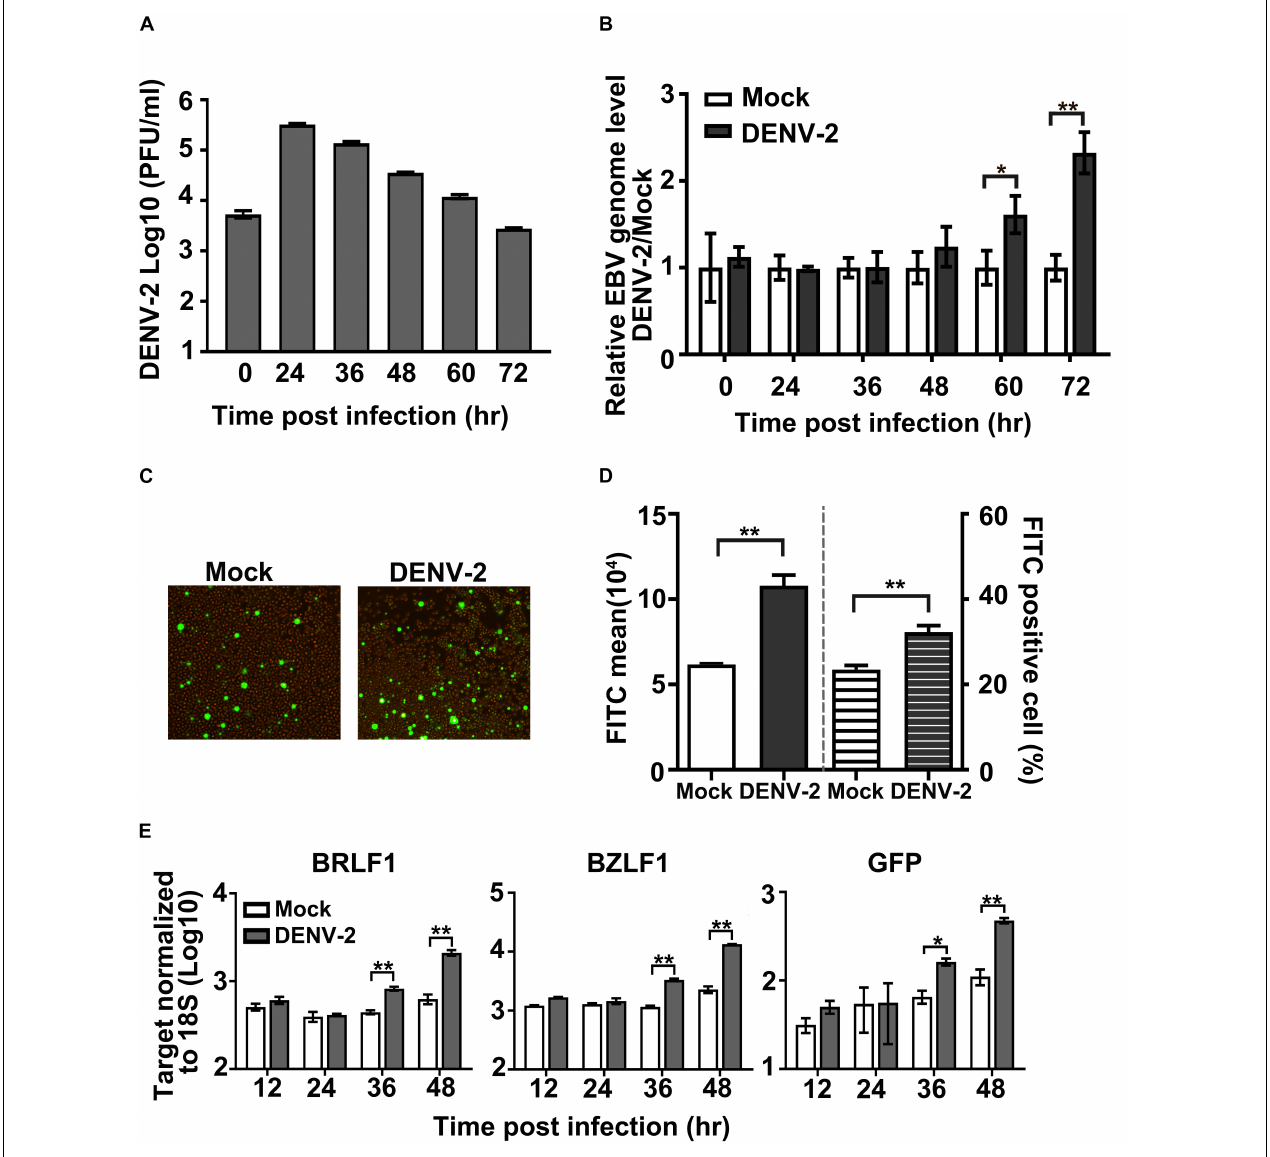
FIGURE 1 | Effect of DENV-2 infection on Epstein–Barr virus (EBV) reactivation in EBV + Akata cells. (A–E) EBV + Akata cells were mock-infected or infected with DENV-2 at a multiplicity of infection (MOI) of 10. At the indicated hour post-infection (hpi), DENV-2 titers in the culture medium were determined by plaque assay (A) . Cell-associated EBV genome copy number was measured by qPCR and normalized to glyceraldehyde 3-phosphate dehydrogenase (GAPDH). DENV-2-infected groups were normalized to mock-infected group (set as 1) at all time points post-infection and plotted as in panel B . At 72 hpi, green fluorescent protein (GFP) level in mock or DENV-2-infected EBV + Akata cells was photographed under a fluorescence microscope (C) or quantified by flow cytometer (D) . The empty and filled columns on the left half of the chart in panel D represented fluorescein isothiocyanate (FITC) mean value, and the striped columns on the right half represented the percentage of FITC-positive cells. mRNA level of BRLF1, BZLF1, and GFP at the indicated time points post-dengue infection was quantified by RT-qPCR, normalized to 18S rRNA, and plotted (E) . p < 0.01 was marked as ** and p < 0.05 was marked as